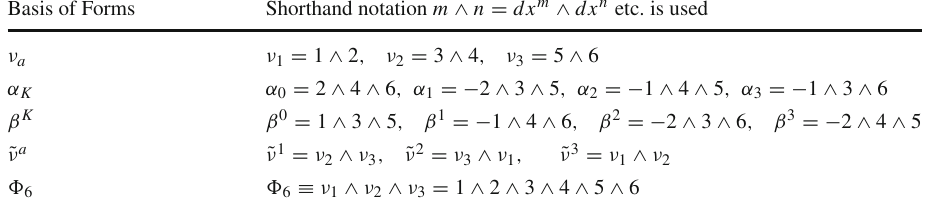
Table 7 Bases of the various Basis of Forms Shorthand notation m ∧ n = dx m ∧ dx n etc. is non-trivial forms for Model A